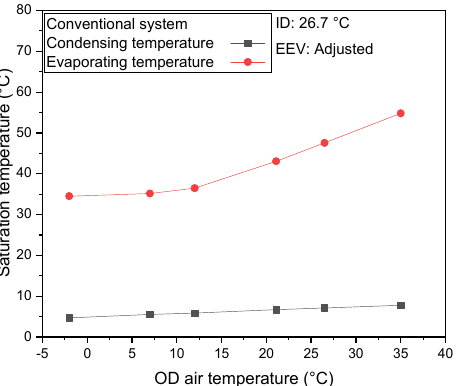
Figure 5. Degree of subcooling of conventional cooling system according to OD air temperature.